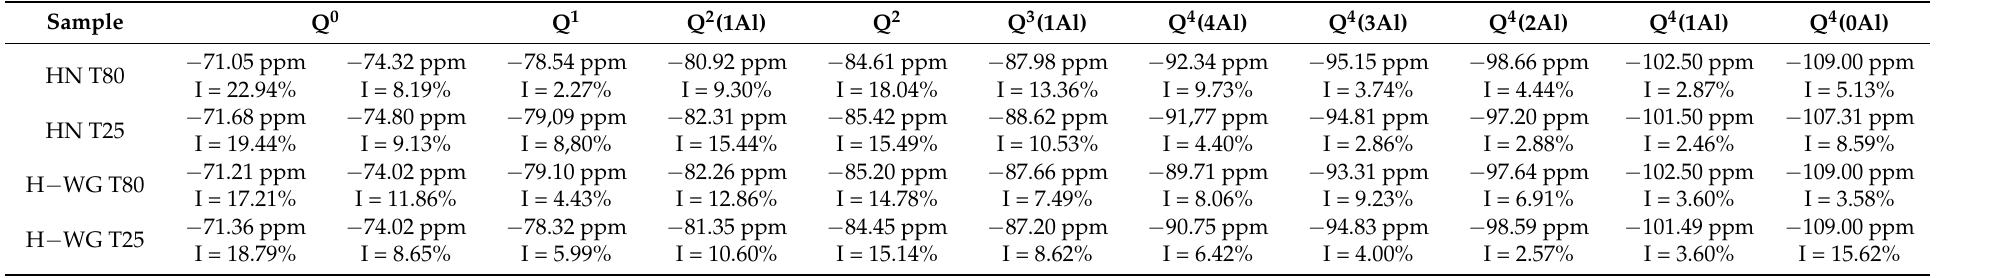
Table 8. Signal positions and intensities on deconvoluted 29 Si MAS − NMR spectra for 28 days hybrid cement